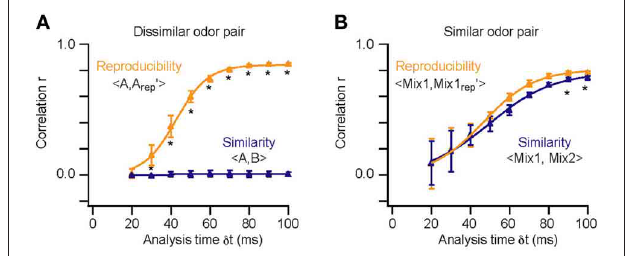
FIGURE 7 | Stimulus reproducibility and similarity in the model. Similarity and reproducibility for repetitions of a dissimilar [ A vs. B ; (A) ] and similar odor pair [Mix1:60A/40B vs. Mix2:40A/60B; (B) ] as a function of the analysis time window ( δ t ). Asterisks ( ∗ ) highlight times at which “reproducibility” was significantly higher than “similarity” ( p < 10 − 4 ). Error bars indicate SD for the eight repetitions of each comparison. Thick lines are sigmoidal fits of the correlation